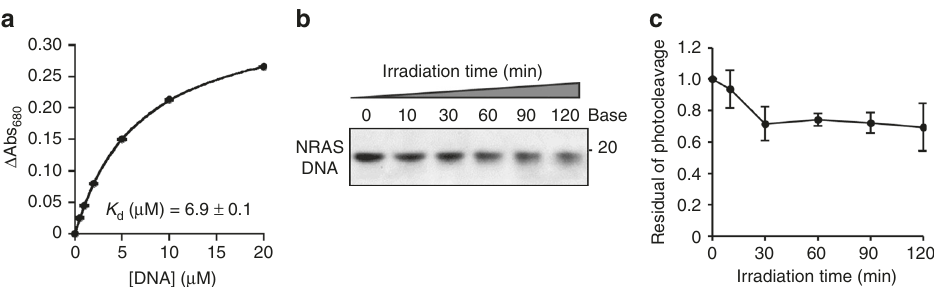
Fig. 4 ZnAPC binds to NRAS DNA. a Plots of Δ Absorbance at 680 nm ( = absorbance with NRAS DNA minus absorbance without NRAS DNA) of 2 μ M ZnAPC with 0, 0.5, 1, 2, 5, 10 or 20 μ M NRAS DNA at 25 °C. Continuous lines are curve- fi tting results with a theoretical equation, and the estimated K d of ZnAPC with NRAS DNA is also indicated. b Electrophoresis of 0.1 µ M NRAS DNA (in a 10% denaturing polyacrylamide gel) in the presence of 2 µ M ZnAPC after photo-irradiation for the indicated periods. c Residual intact DNA after the photo-cleavage. Error bars represent mean ± SD; n